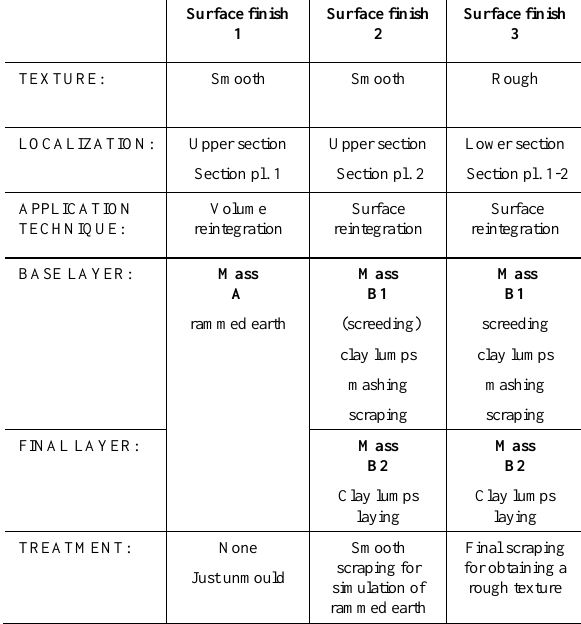
Figure 12. Different types of surface finish: 1-2-3 (Table